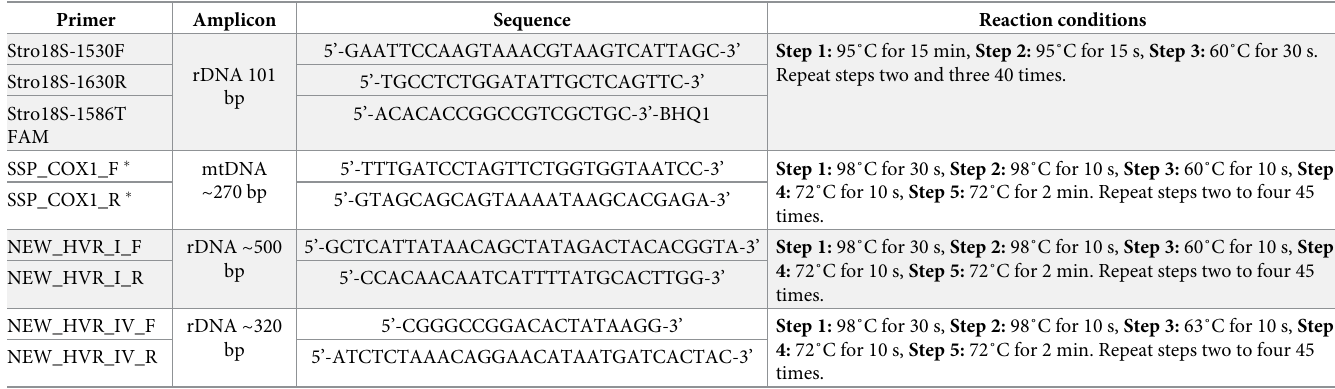
Table 1. Primers and probes and PCR